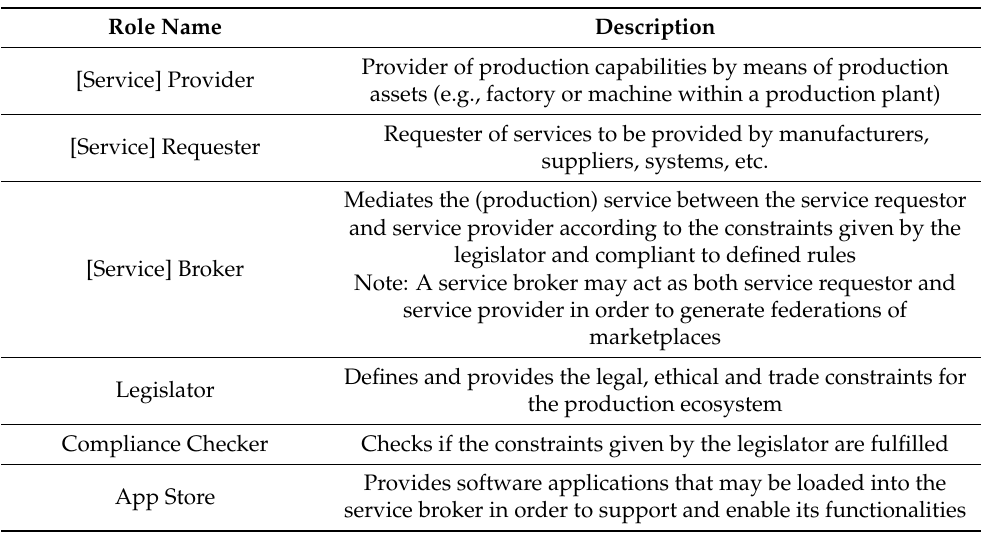
Table 1. Stakeholder roles of industrial marketplaces (note: the prefix [Service] is optional).